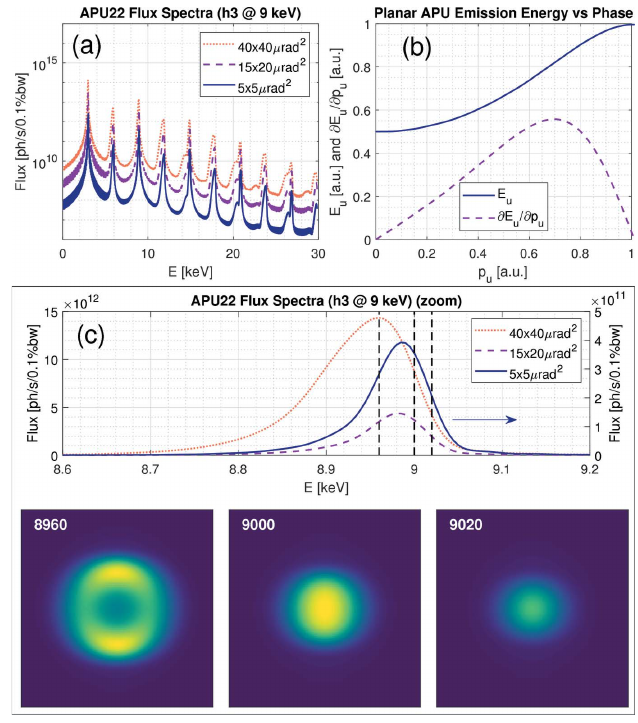
Figure 4 ( a ) Example of the emission flux spectra of the planar adjustable-phase undulators APU22 installed at EMA and MANACA´ at Sirius, with the third harmonic tuned at 9 keV. The first nine harmonics are shown for a given deflection parameter K u , and three different beamline angular acceptance windows (v (cid:6) h) illustrate its effect in peak energy width and flux. ( b ) Arbitrarily scaled energy value E u for a given emission harmonic n u and its derivative with respect to phase, for a normalized undulator phase p u in a planar APU, according to (14). ( c ) Top: zoomed spectral flux plot of the example emission of ( a ), highlighting the broadening of the peak and its shift to lower energies for larger angular acceptances; bottom: ‘slitless’ wave-propagation simulations showing the beam profile for perfectly monochromatic energies at and around the 9 keV resonance (black vertical dashed lines in the